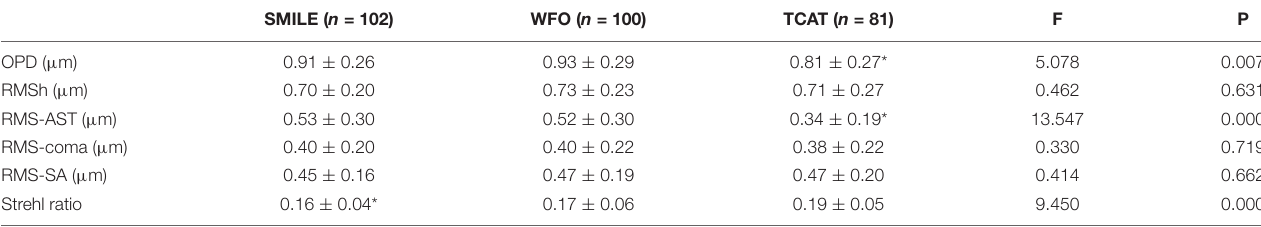
TABLE 4 | Comparison of corneal aberrations and optical quality among the three groups at 6 months